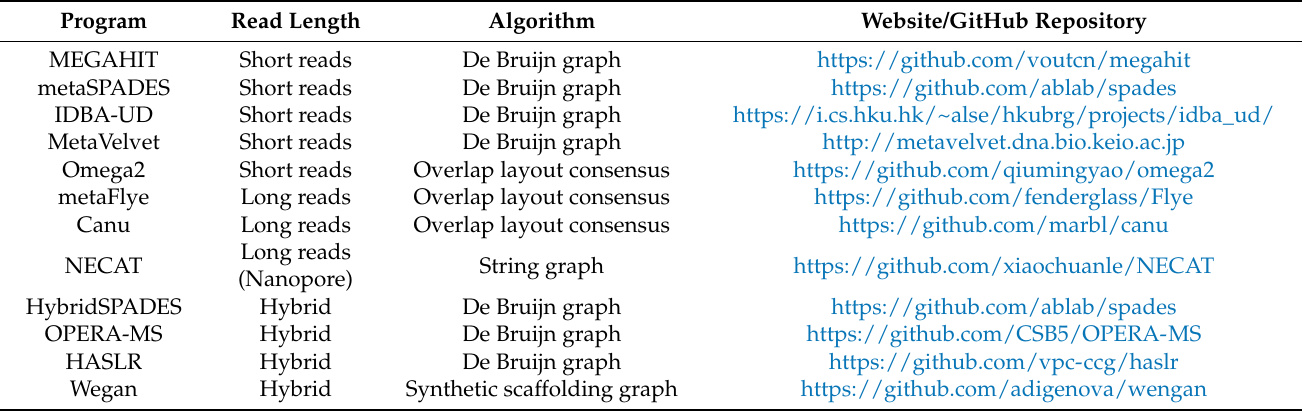
Table 4. Bioinformatic tools for metagenome assembly for short-read, long-read, and hybrid assem- blies. All websites/GitHub Repository links were accessed on 23 December